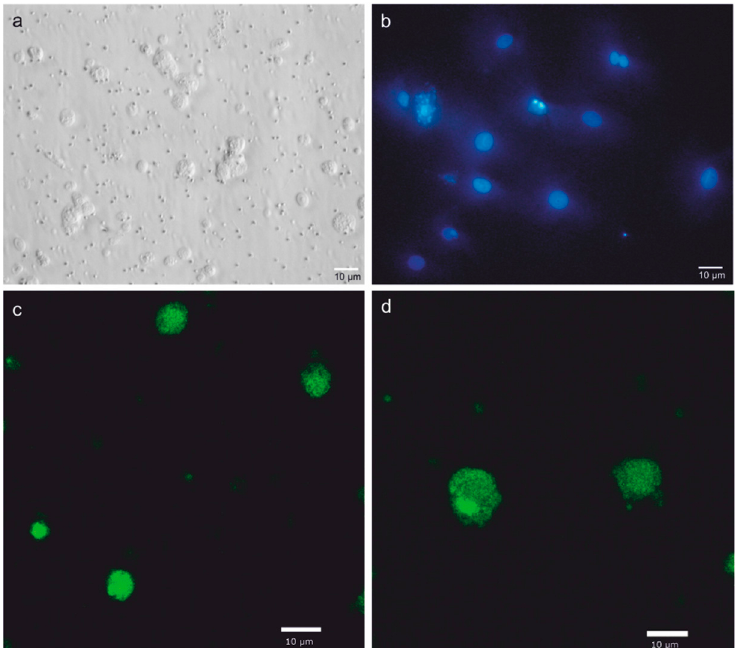
Figure 6. Characterization of meagre spermatogonial stem cells (SSCs) cultured in vitro. Photomicrographs of cells exhibiting round-shape morphology, as observed via phase contrast microscopy ( a ), and presence of nuclei and small cytoplasm, as observed via epifluorescence microscopy after Hoechst staining ( b ). Confocal microscopy evaluation revealed anti-oct4- ( c ) and anti-vasa-positive ( d ) cells after 14 days of in vitro culture.